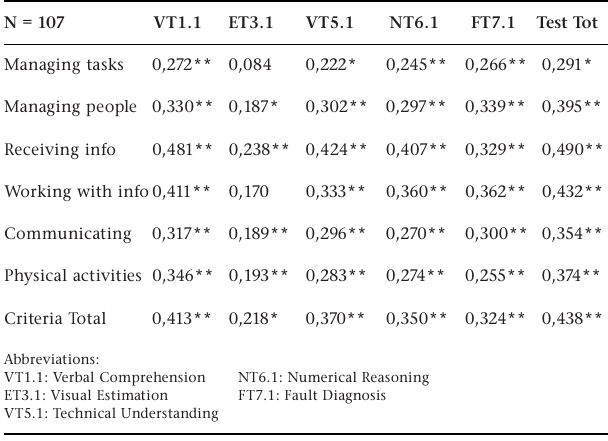
NT6.1: Numerical Reasoning ET3.1: Visual Estimation FT7.1: Fault Diagnosis VT5.1: Technical